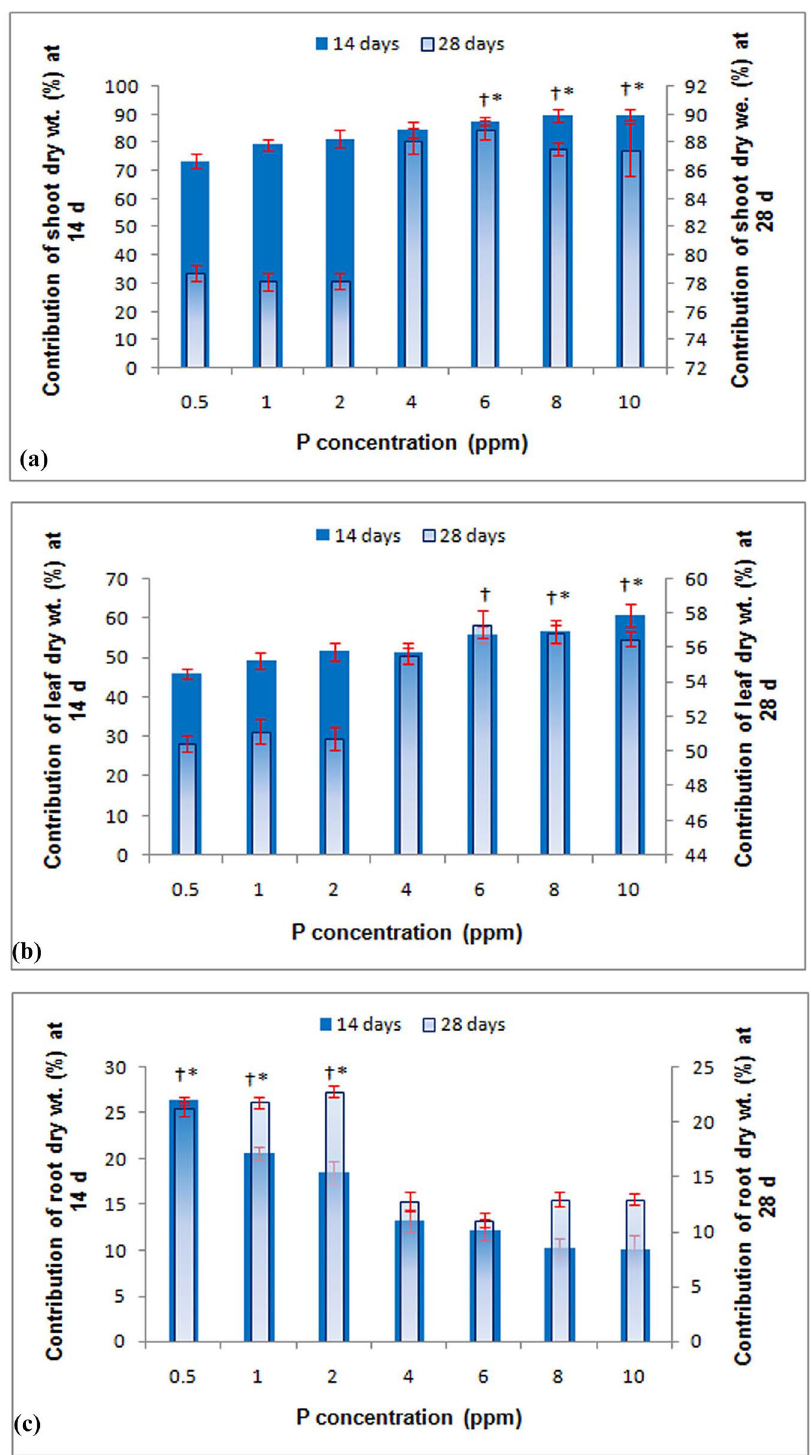
Figure 2. Percentage contribution of shoot/leaf/root to the whole plant under different concentrations of phosphorus in a hydroponic experiment at 14 d and 28 d. Vertical bars represent standard deviation. *p = 0.05 at 14 d, † p = 0.05 at 28